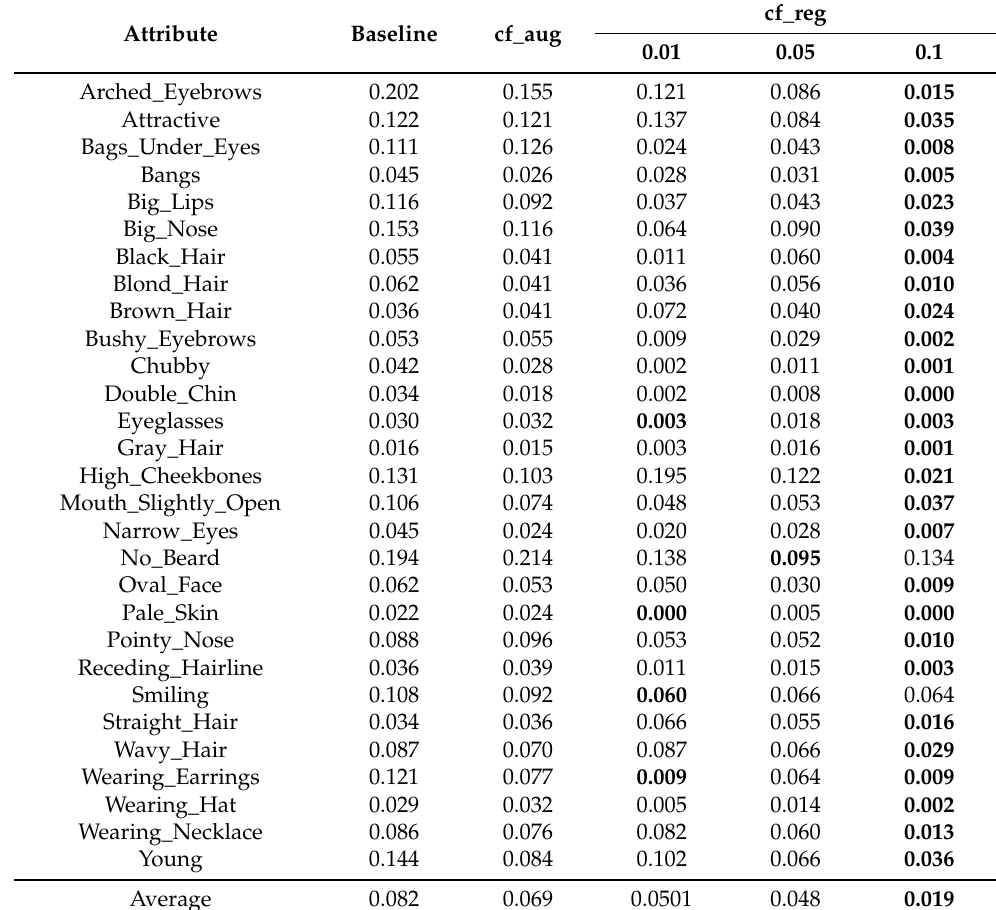
Table 2. The comparison of the averaged counterfactual parities for various algorithms on CelebA. The averaged counterfactual disparities are measured for λ cf = 0.01, 0.05, and 0.1 in the columns cf_reg. The bold number represents the lowest value of averaged counterfactual disparity per